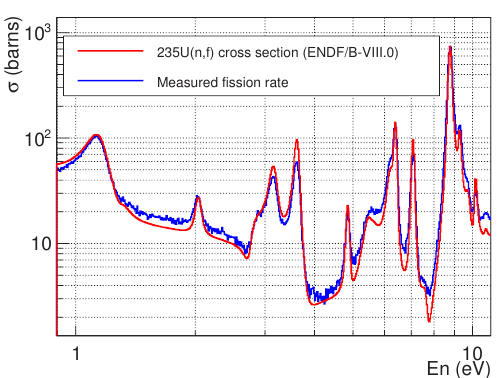
Figure 3: Comparison of the measured fission rate of 235 U and its fission cross-section from ENDF / B-VIII.0 [12] for calibrating the neutron flight